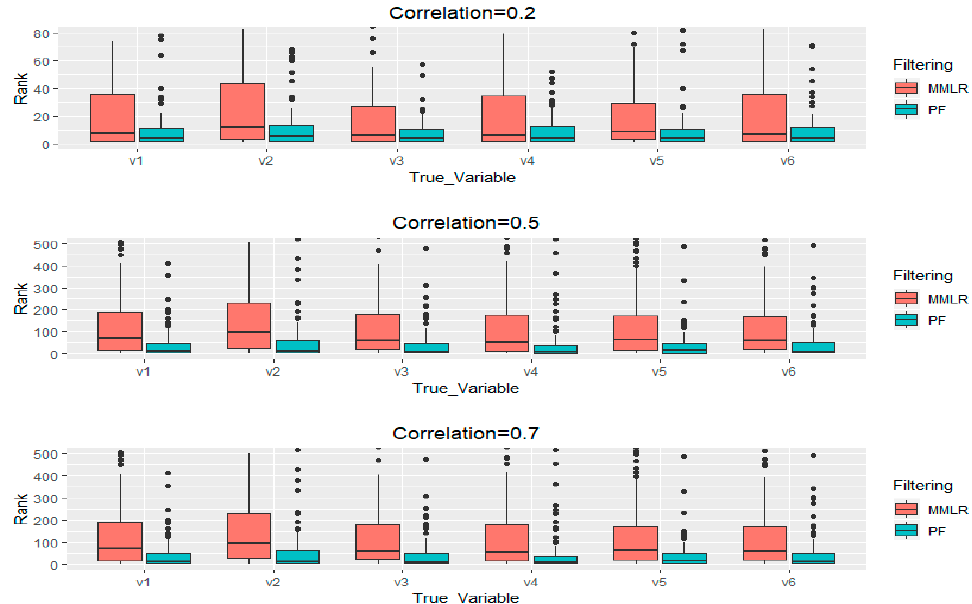
Figure 2. The boxplots of ranking true variables with the proposed filter method (PF) and MMLR method under correlation coefficients 0.2, 0.5, and 0.7 with 100 iterations.